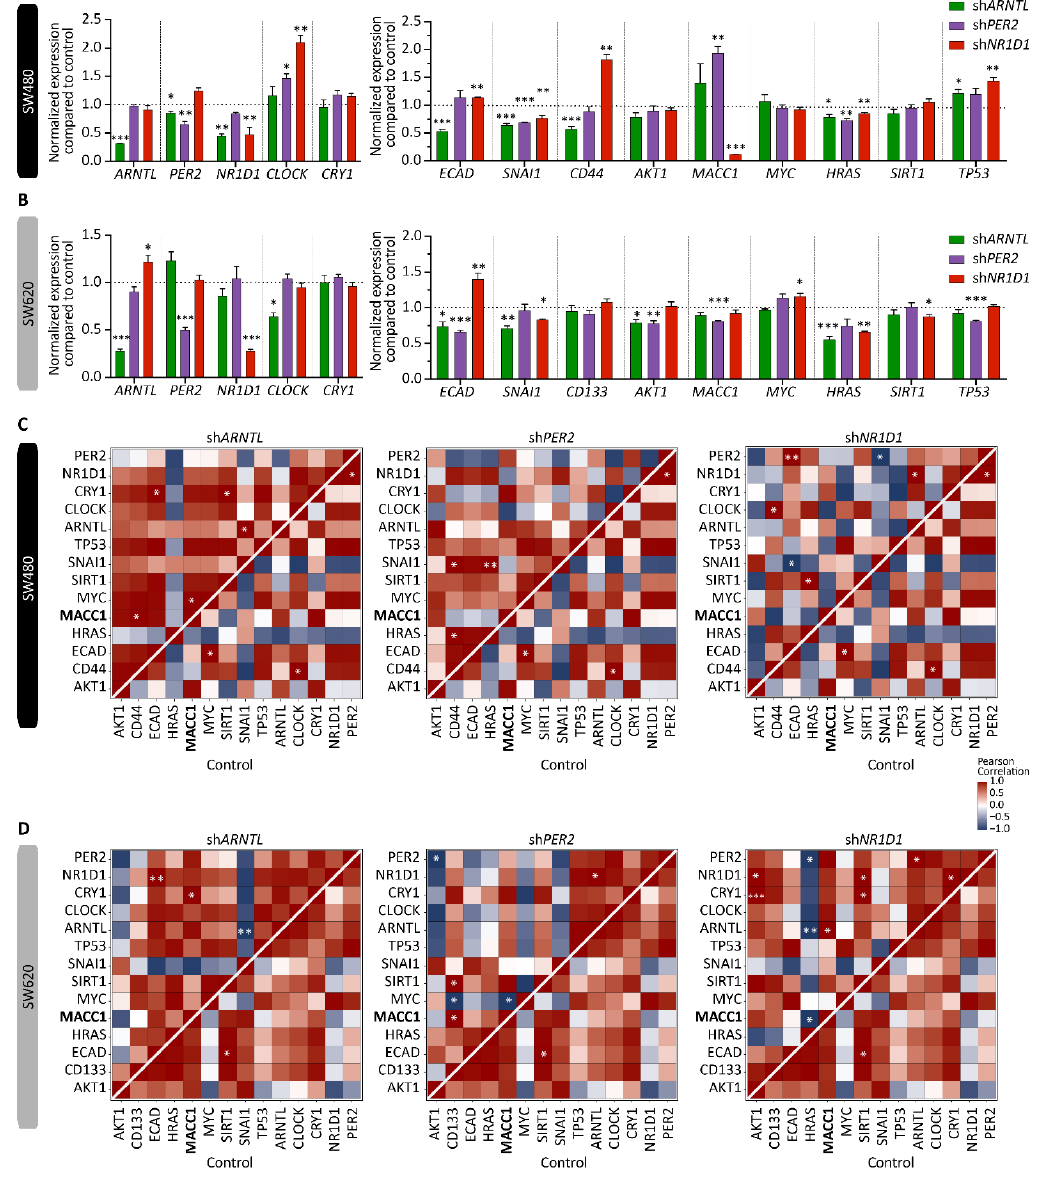
Figure 2. Core-clock manipulation affects EMT gene expression in SW480 and SW620 cells. Gene expression analysis of core-clock genes PER2 , CRY1 , NR1D1 , CLOCK , and ARNTL as well as EMT-related genes in control and core-clock knockdown (sh ARNTL , sh PER2 and sh NR1D1 , respectively) cell lines in SW480 ( A ) and SW620 ( B ) cells at 24 h after synchronization ( n = 3, mean ± SEM). Heatmaps of Pearson correlations between each pair of core-clock and EMT-related genes for ( C ) SW480 and ( D ) SW620 sh ARNTL , sh PER2 and sh NR1D1 cells compared with the control cell line. * p < 0.05, ** p < 0.01, *** p < 0.001; two-tailed unpaired t -test.